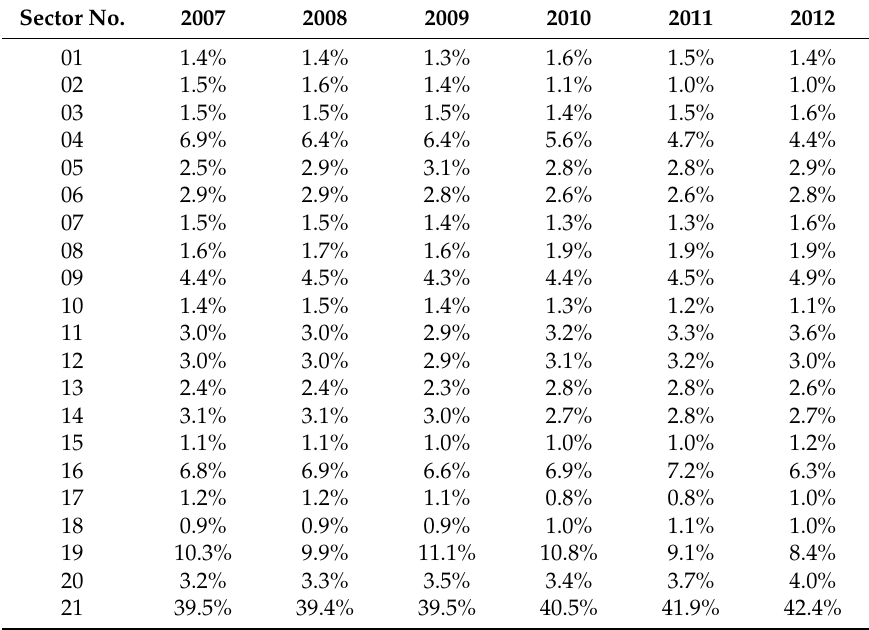
Table 3. The proportion of fixed assets invested by each sector.